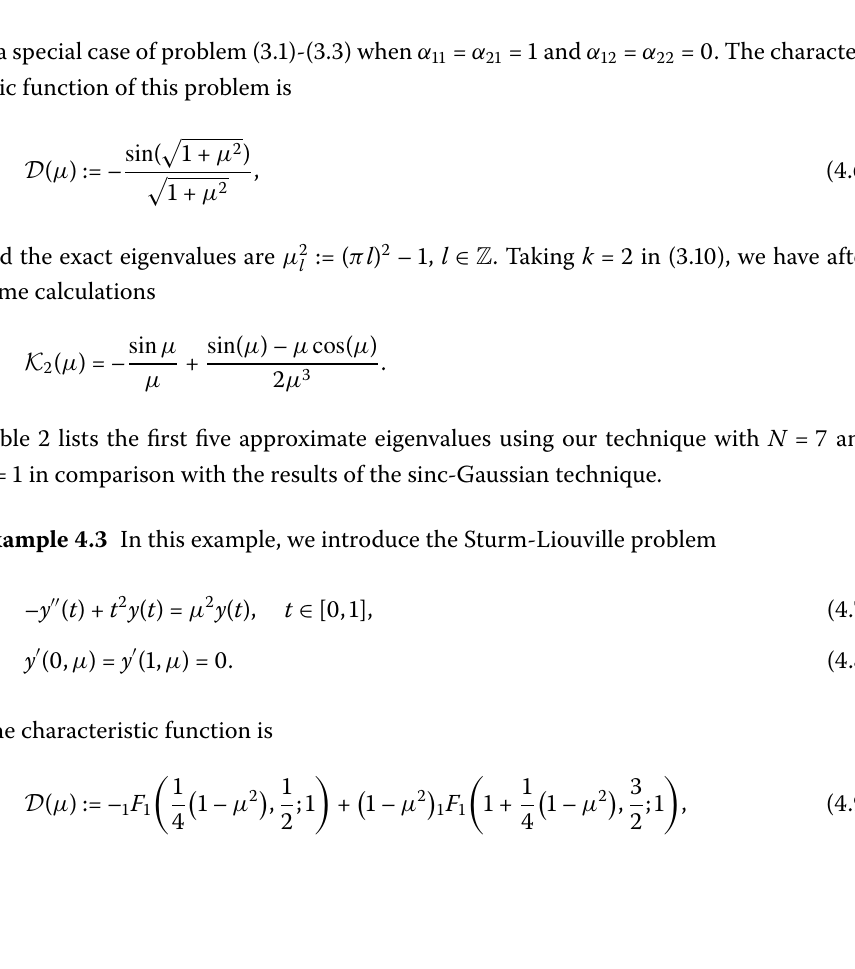
and then U  ∈ B ∞ . Table  shows the first five approximate eigenvalues of problem 